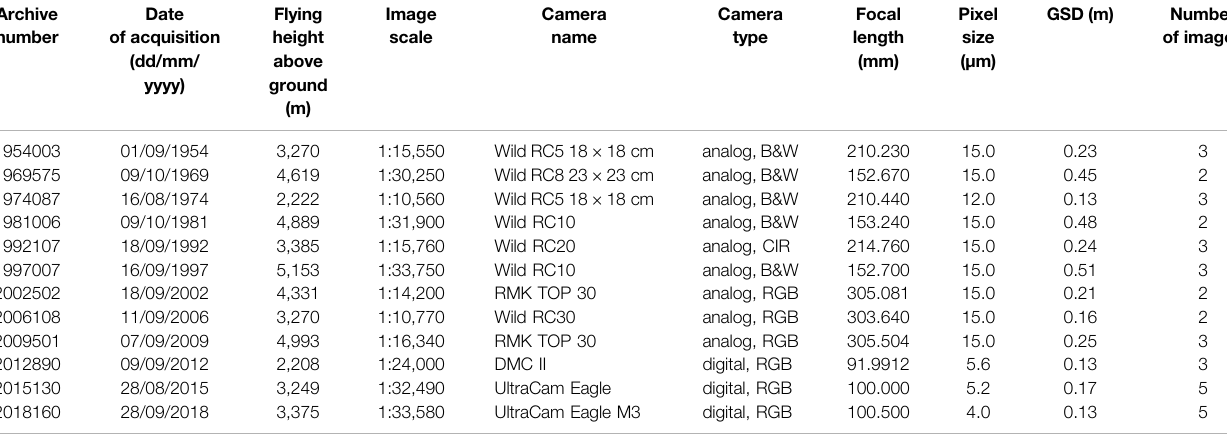
B&W, black and white; CIR, color infrared; RGB, red, green, blue.